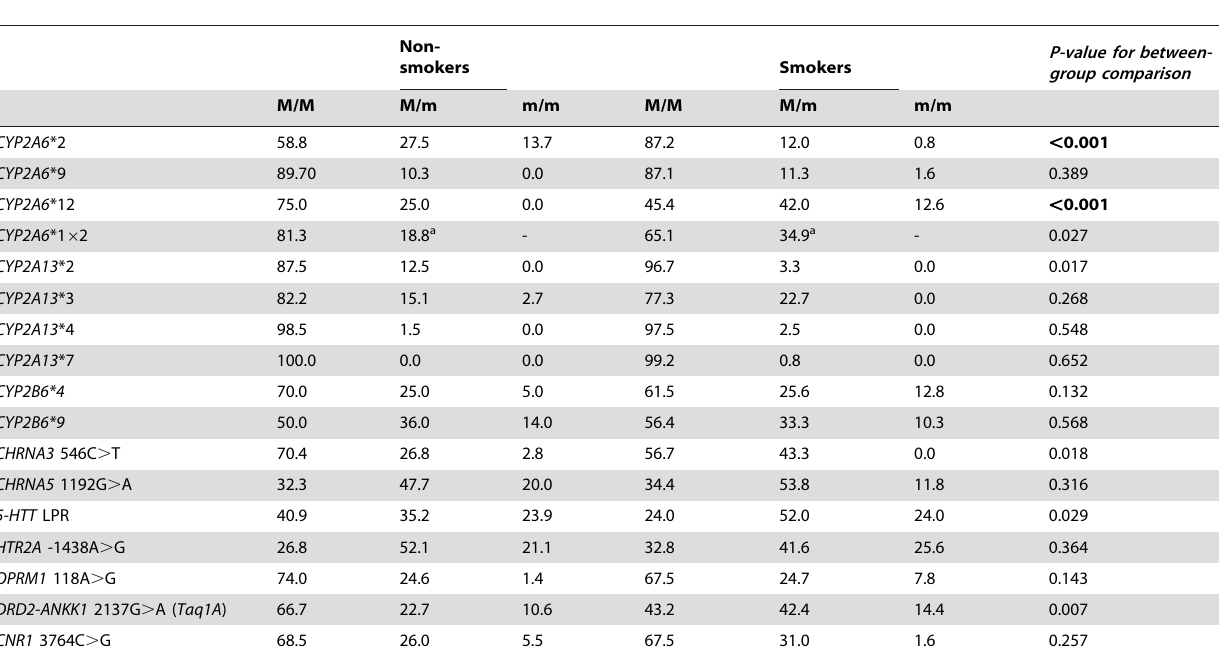
Table 2. Genotype frequency distributions (%) in the two study group, i.e. controls (non-smokers) and cases